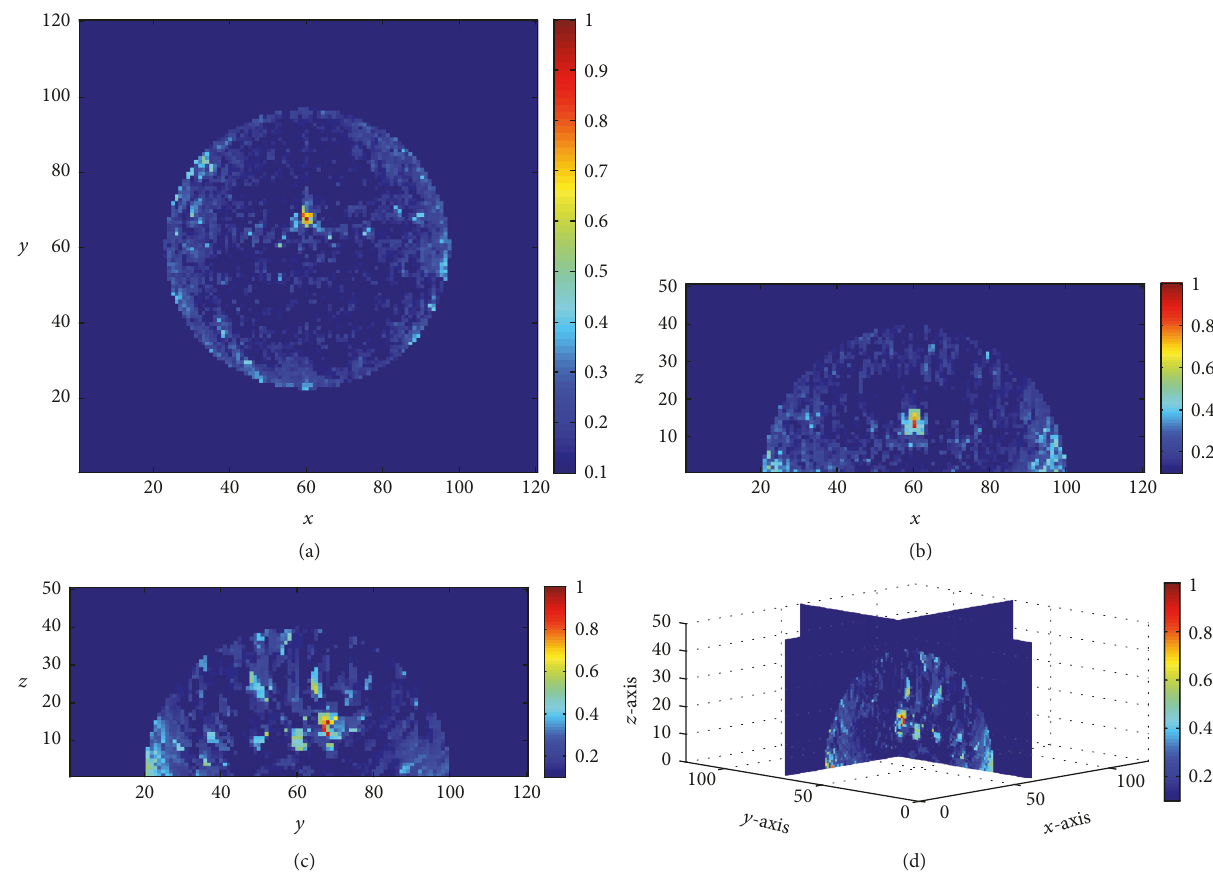
Figure 33: Cross-sectional images of restored breast model with 1,000 measurements, (a) 𝑥 - 𝑦 plane, 𝑧 = 17 , (b) 𝑥 - 𝑧 plane, 𝑦 = 70 , (c) 𝑦 - 𝑧 plane, 𝑥 = 60 , and (d) 3D image